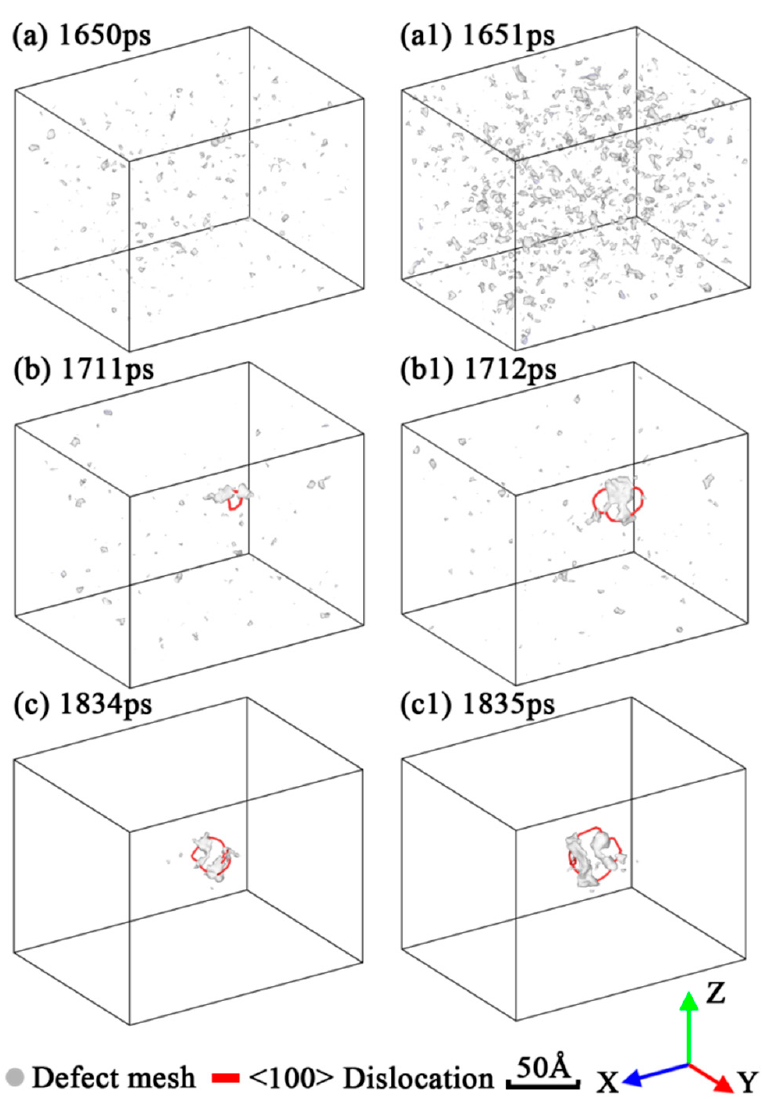
Figure 5. Dislocation and defect mesh in the fracture process of Mono-Si under three strain rates: ( a , a1 ) 10 − 2 /ps; ( b , b1 ) 10 − 4 /ps; ( c , c1 ) 10 − 6 /ps. The atoms were removed for